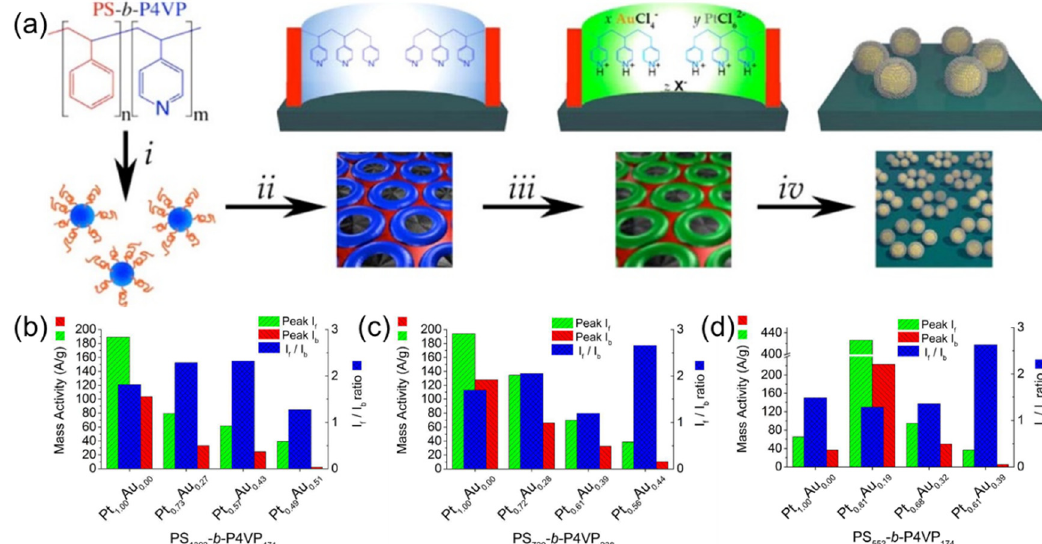
Figure 5. ( a ) Schematics of synthetic procedure for the synthesis of PtAu bimetallic, core-shell catalysts, using thin films of PS– b –P4VP micelles. (i) Solution self-assembly of PS– b –P4VP into spherical micelles in toluene; (ii) spin-coating micelles onto an electrode substrate, followed by thin film reconstruction into an array of open micelles by soaking in methanol; (iii) simultaneous loading of K 2 PtCl 6 and KAuCl 4 metal precursors into micellar array by immersion into a stoichiometrically tuned, aqueous solution of the respective metal ions; (iv) removal of PS– b –P4VP template by reductive Ar plasma etching. ( b – d ) Electrocatalytic activity charts for peak mass activity, I f and I b , and I f / I b ratio observed during 50 cycles of methanol oxidation for PtAu core-shell NPs, with varied Pt/Au ratios created from PS 1392 – b –P4VP 471 ( b ), PS 720 – b –P4VP 238 , ( c ) and PS 552 – b –P4VP 174 ( d ). Subscripts in BCP assignments indicate the average number of PS and P4VP units in BCP composition, whereas I f and I b denote the forward and reverse anodic peak current, respectively, derived from cyclic voltammetry experiments for methanol oxidation. Adapted from [25].